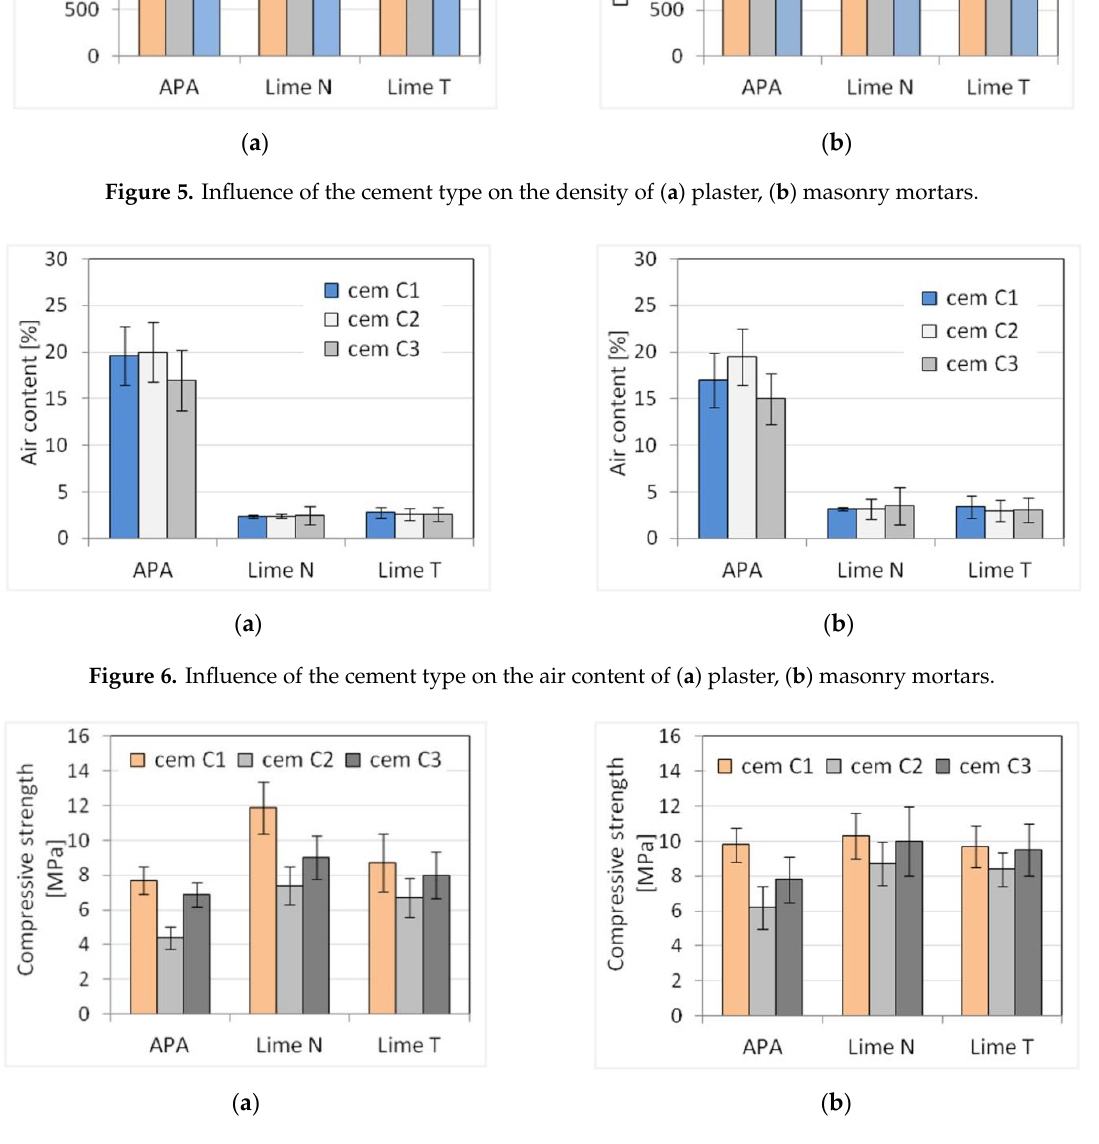
Figure 7. Influence of the cement type on compressive strength of ( a ) plaster, ( b ) masonry mortars.